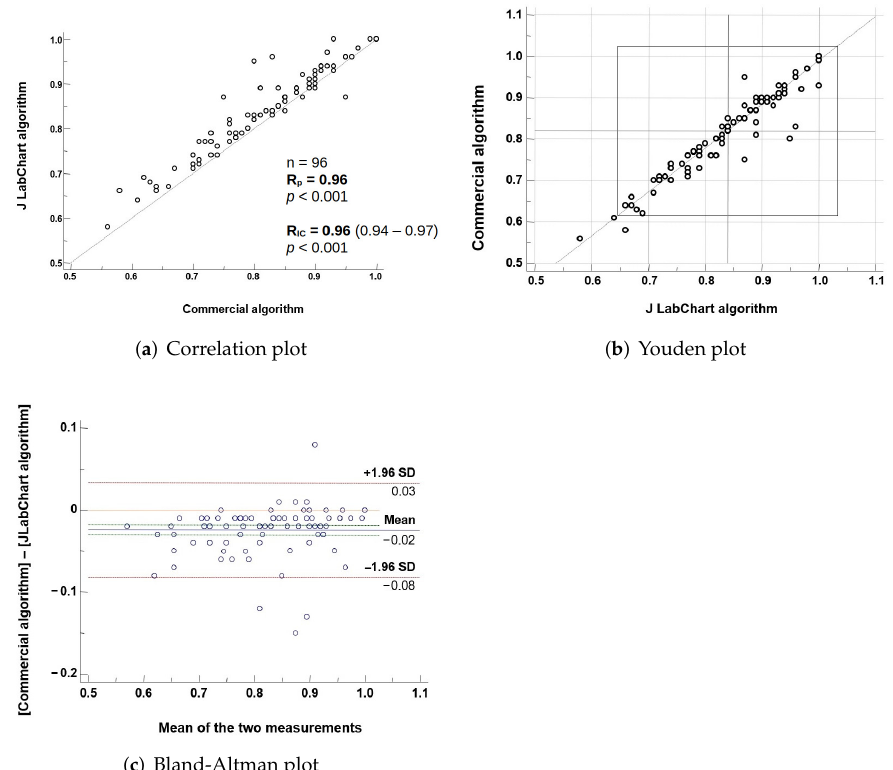
Figure 10. Statistical analysis results for the FFR index between commercial software and JLabChart.